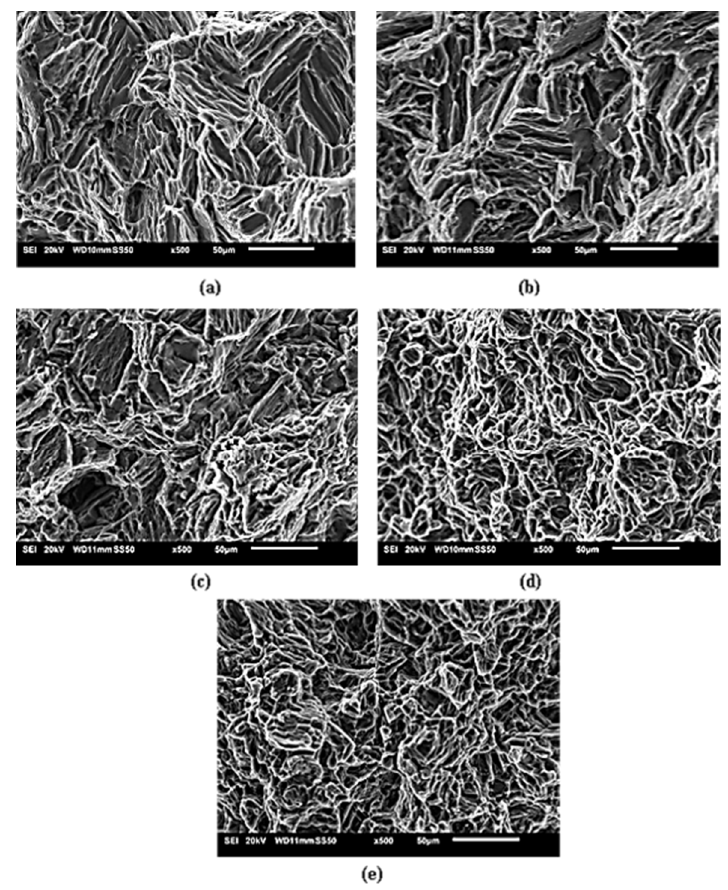
Figure 5. Tensile fractography of ( a ) Pure Mg, ( b ) Mg0.5NiTi, ( c ) Mg1NiTi, ( d ) Mg1.5NiTi and ( e ) Mg3NiTi nanocomposites.